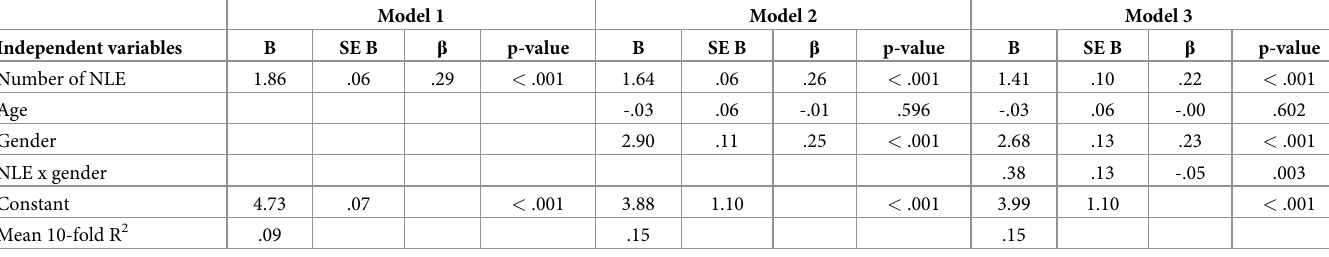
Table 2. Regression of number of negative life events as a predictor of symptoms of